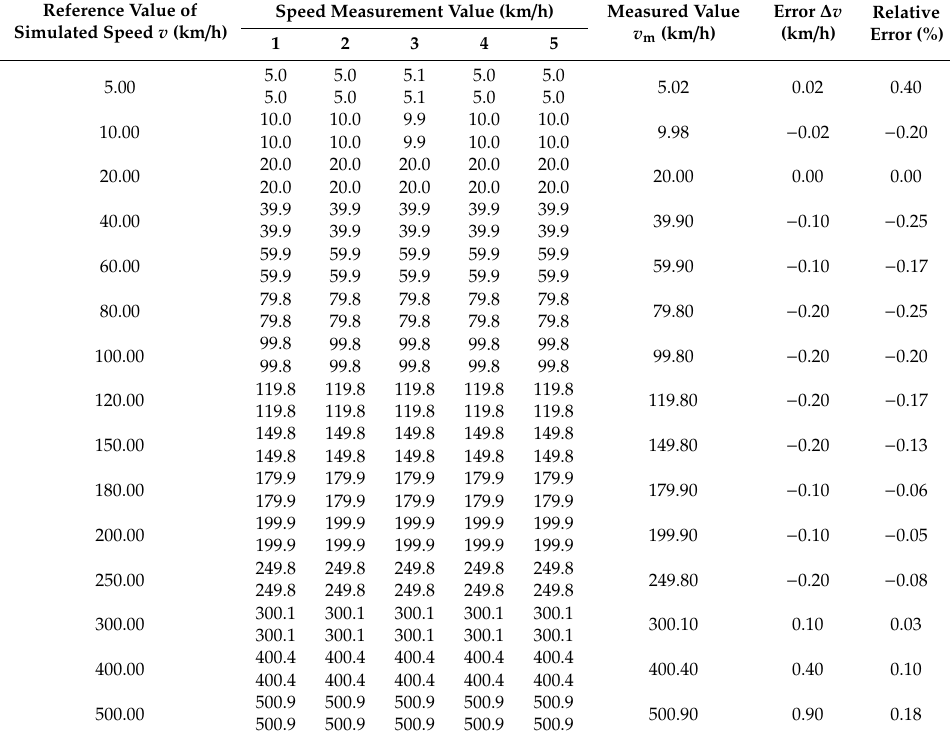
Table 10. Numerical speed calibration results of the DRS05 / 1a